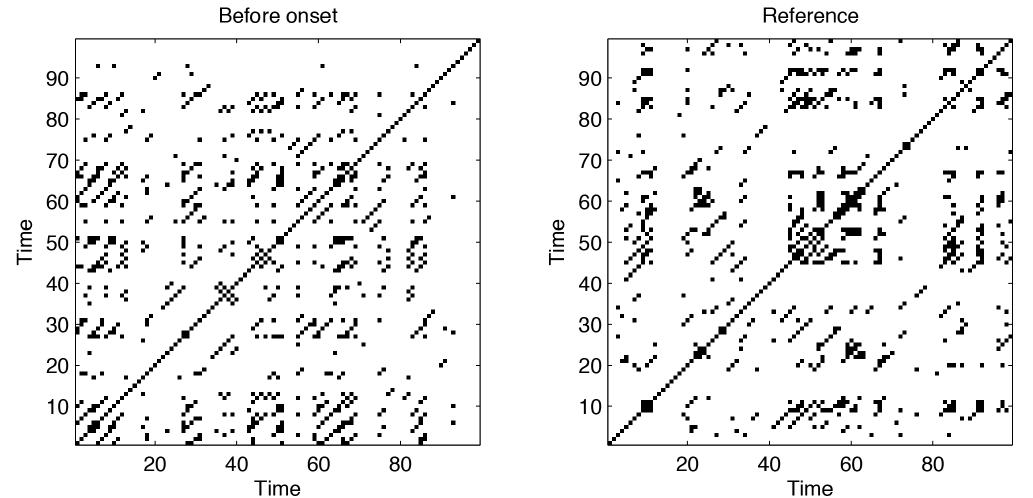
Figure 3. Exemplary recurrence plot before transition point onset (left) and the reference period (right). Embedding dimension m (cid:2) ~ 3 , embedding delay t ~ 1 , recurrence threshold e ~ 0 : 7 , window size w ~ 100 .